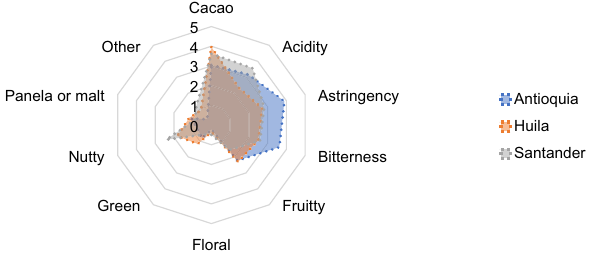
Figure 6. Sensory profile of cocoa liquor from Antioquia, Huila and Santander .